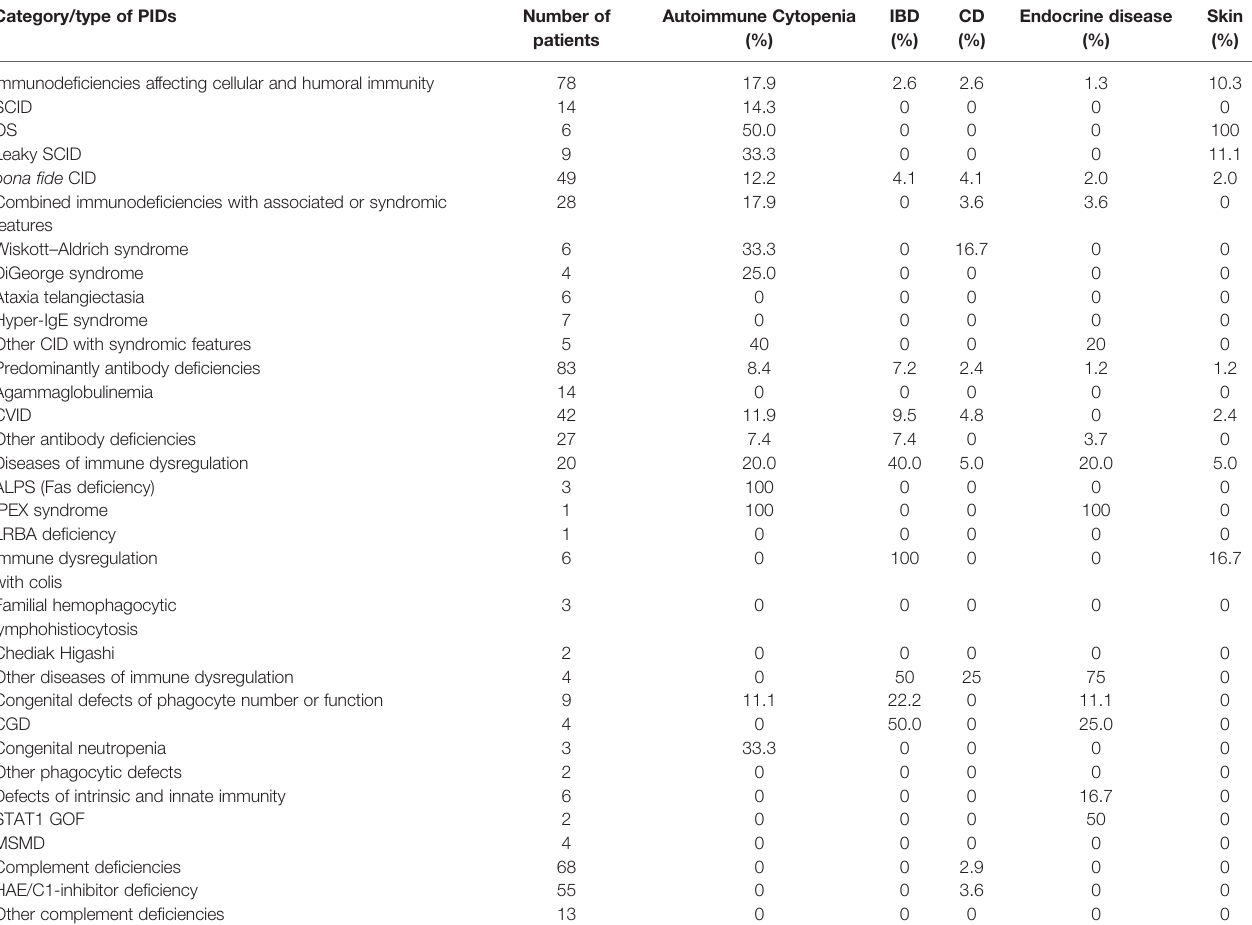
TABLE 5 | Distribution of major autoimmune diseases among different categories/types of PIDs. Category/type of